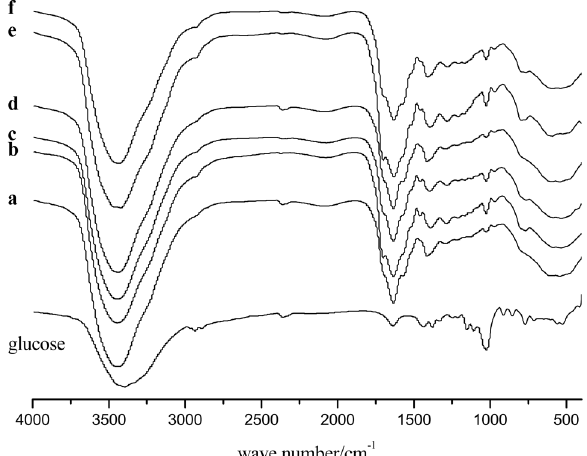
Figure 4: FTIR of glucose and carbon microspheres prepared under di ff erent conditions. Samples ( a – c ) were prepared at 90°C for 30 min with di ff erent concentrations of HCl: ( a ) 18.5%, ( b ) 25.9%, ( c ) 37.0%. Samples ( d – f ) were prepared at 90°C for 120 min with di ff erent concentrations of HCl: ( d ) 18.5%, ( e ) 25.9%, ( f ) 37.0%.